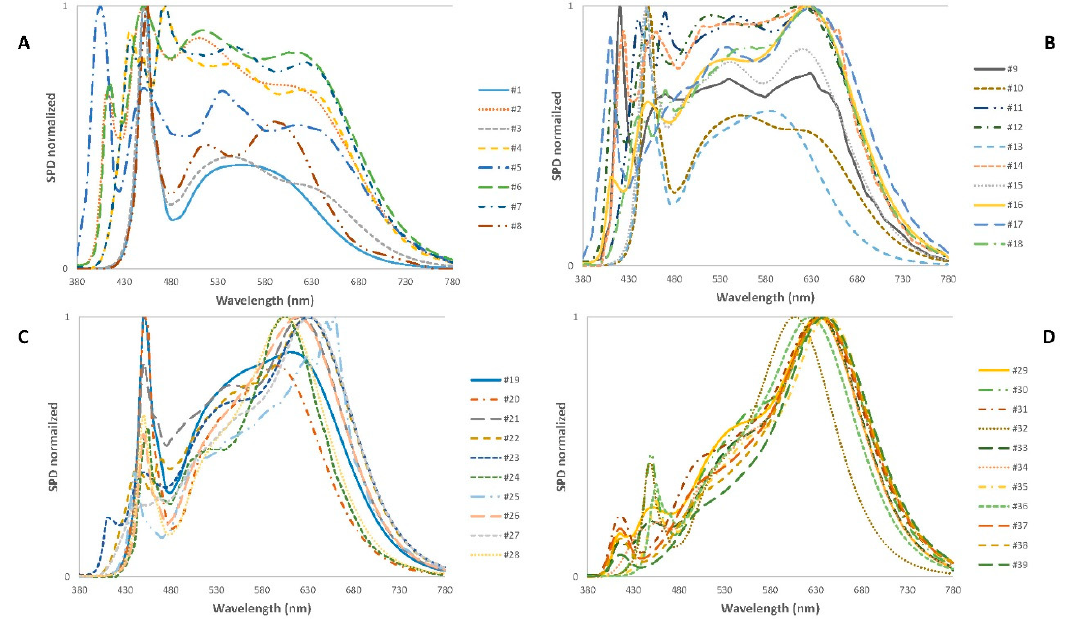
Figure 1. Spectral power distributions of LEDs divided by Correlated Color Temperature (CCT). ( A ) >5001 K series, ( B ) 4001–5000 K series, ( C ) 3001–4000 K series, and ( D ) <3000 K series.